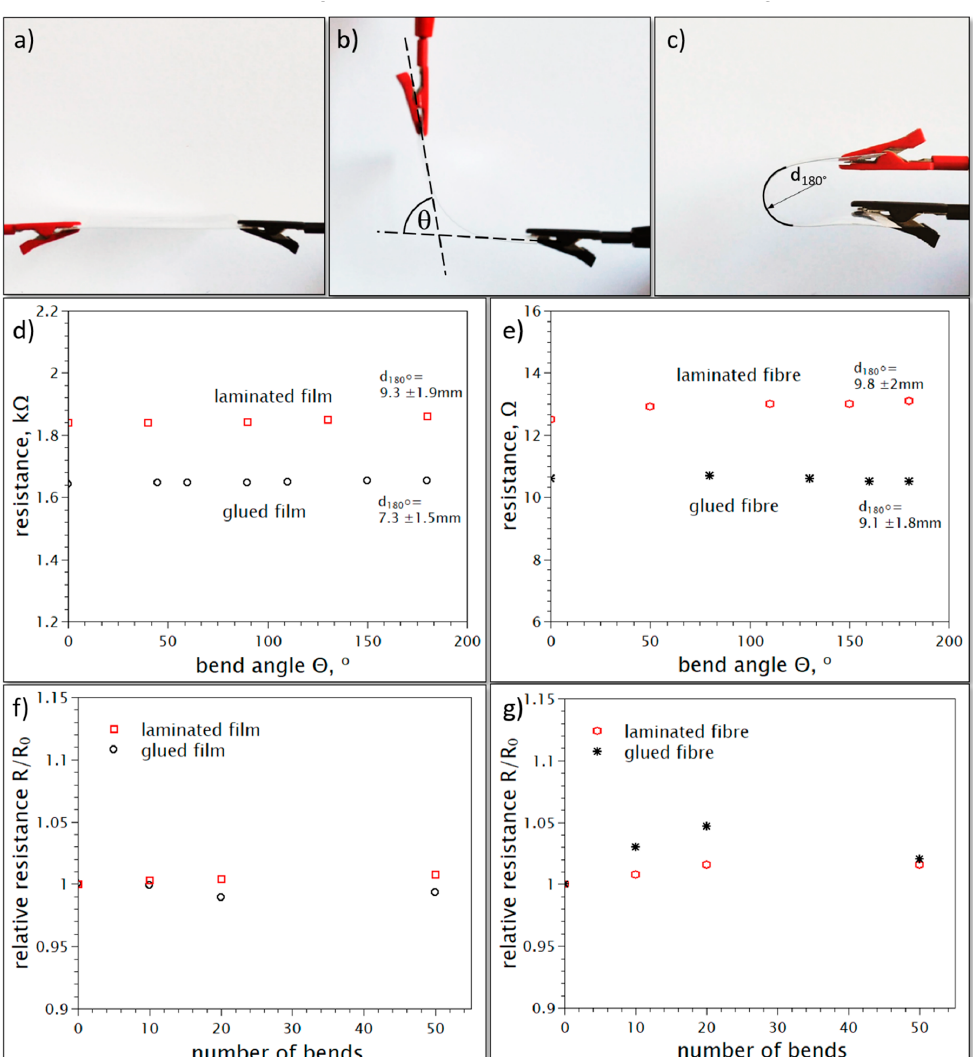
Figure 7. Measurement of the resistance change upon the bending of the flexible component. ( a ) Initial resistance measurement (performed before bending). ( b ) Measurement of the bend angle and ( c ) diameter of the 180° bend. ( d ) Changes of the resistance upon bending of the thin film electrode and ( e ) fiber electrodes presented in Figure 6. ( f ) Changes in the resistance of the thin film electrode and ( g ) the fiber electrode presented in Figure 6, bent repetitively at 180°. These changes are presented as values relative to the initial resistance R 0 , recorded after the first test presented in Figure 7f,g. The samples were also tested in their performance as heaters. A thermal camera imaging experiment has shown that the best results in terms of uniformity and hot-spot formation were obtained for laminated CNT fiber samples (Figure 6b,c). The heating and cooling curves obtained for a direct-current DC current of 120 mA and of 170 mA are presented in Figure 6d and the thermal camera images obtained for 120 mA and 170 mA current-induced heating in Figure 6e,f, respectively.